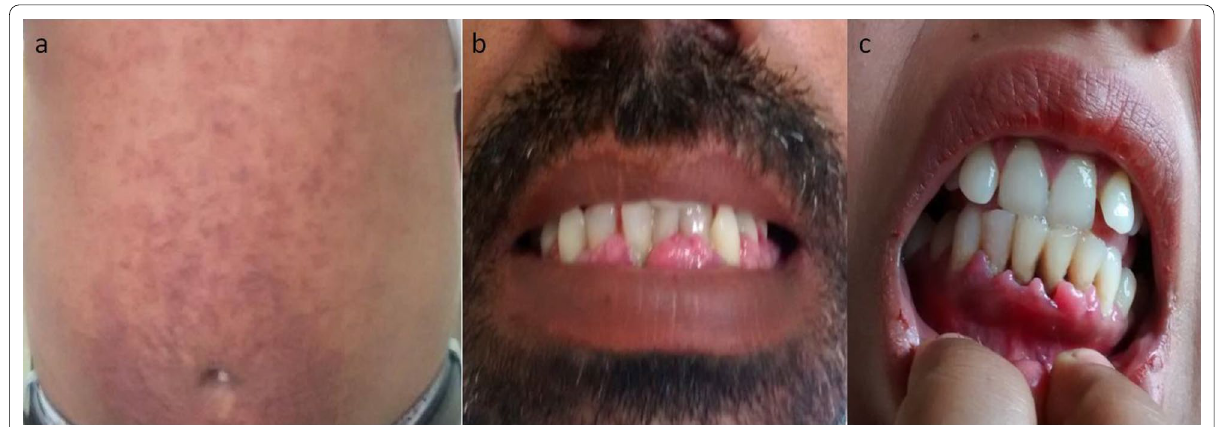
Fig. 2 Photographs show phenytoin-induced drug rash ( A ) and gum hyperplasia ( B and C